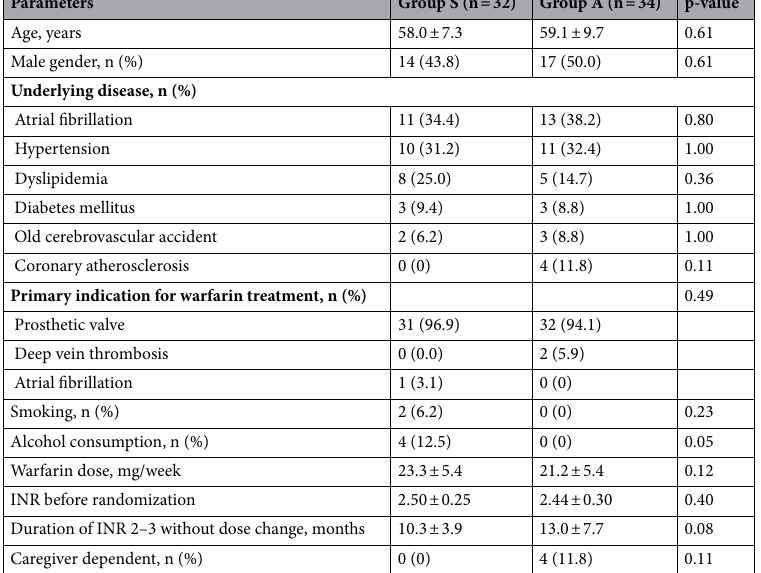
Table 2. Baseline characteristics in the intention-to-treat population. Plus-minus values are means ± standard